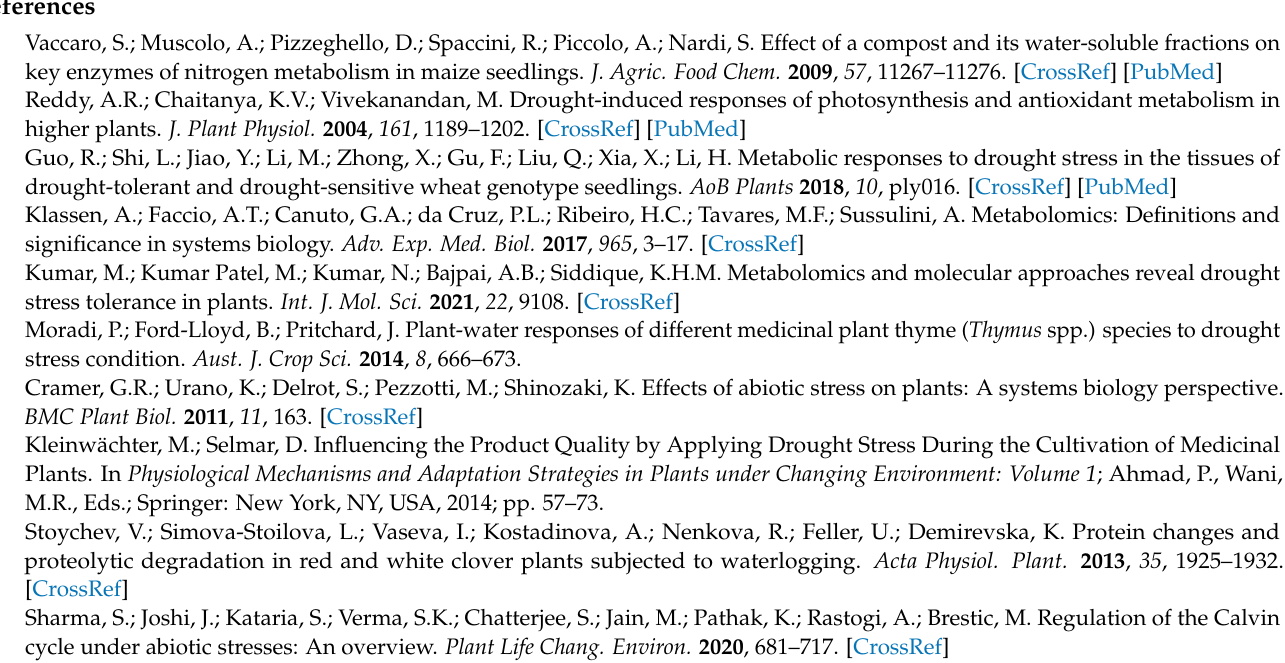
Table S6: Correlation analysis between individual metabolites of the central carbon metabolic routes in Mexican mint ( Plectranthus aboinicus ) plants in response to varying watering